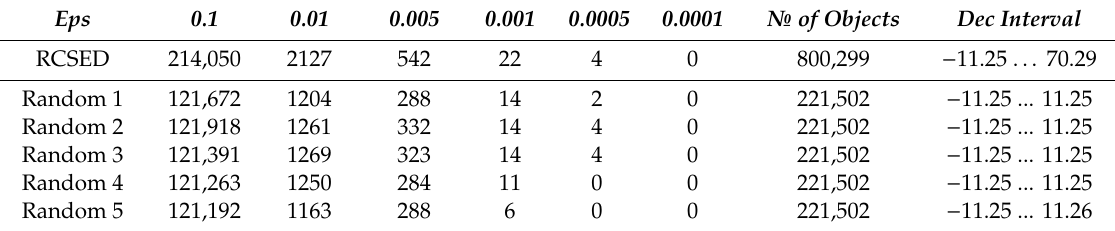
Table 18. Number of opposite pairs for selected angular accuracy values eps in the Reference Catalog of Spectral Energy Distributions of galaxies (RCSED) catalog and in four random catalogs with objects evenly distributed on the celestial sphere within interval of dec values from − 11.25 ◦ to 11.25 ◦ . Eps 0.1 0.01 0.005 0.001 0.0005 0.0001 № of Objects Dec Interval RCSED 214,050 2127 542 22 4 0 800,299 − 11.25 ... 70.29 Random 1 121,672 1204 288 14 0 − 11.25 ... 11.25 Random 2 1261 332 Random 3 121,391 1269 323 14 4 0 221,502 − 11.25 ... 11.25 Random 4 121,263 1250